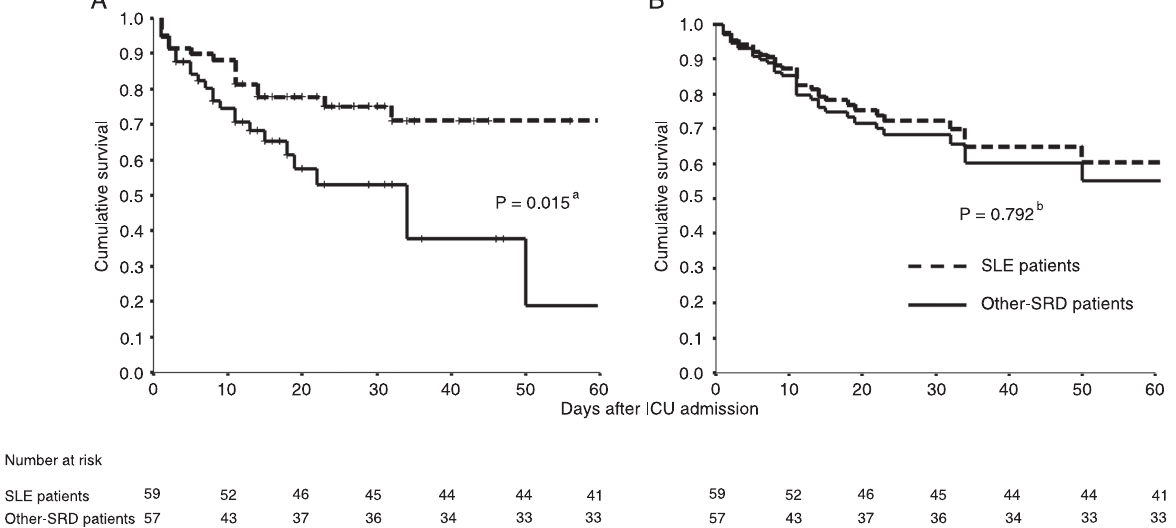
Figure 1. Actuarial 60-day survival among 116 rheumatologic patients with systemic lupus erythematosus (SLE) or other systemic rheumatologic diseases (SRD) after ICU admission. Panel A shows the Kaplan-Meyer probability of crude survival curve, and Panel B shows the 60-day probability of the survival curve adjusted for age, gender, chronic renal failure, chronic lung disease, admission syndrome, and hemorrhage evidence. a P value using the log-rank test. b P value using the Cox proportional-hazards regression model with the non-balanced variables between groups as